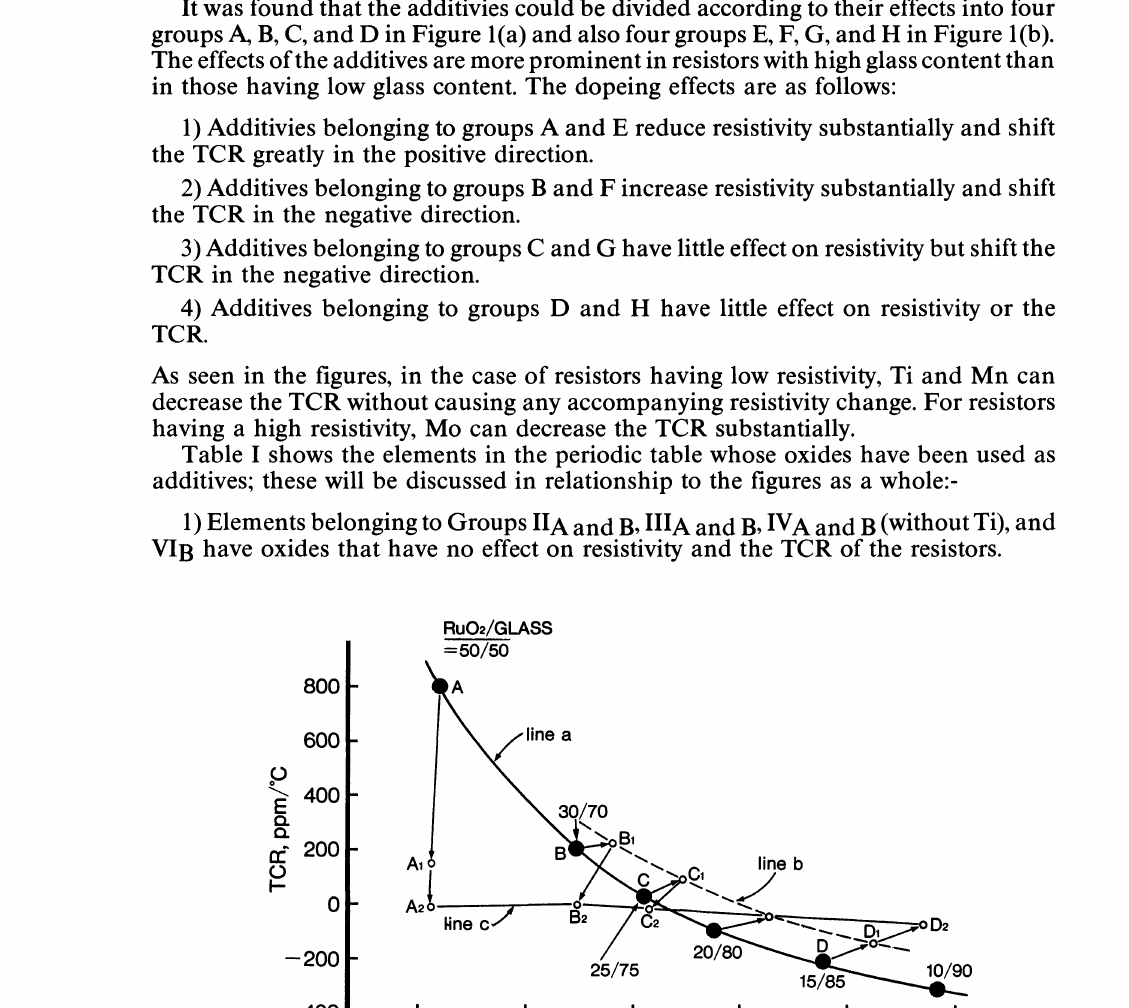
Relation between resistivity and TCR for specimens with added lanthanum oxides. 2wt% oxides were added to RuO/glass---15/85. Specimens were fired at